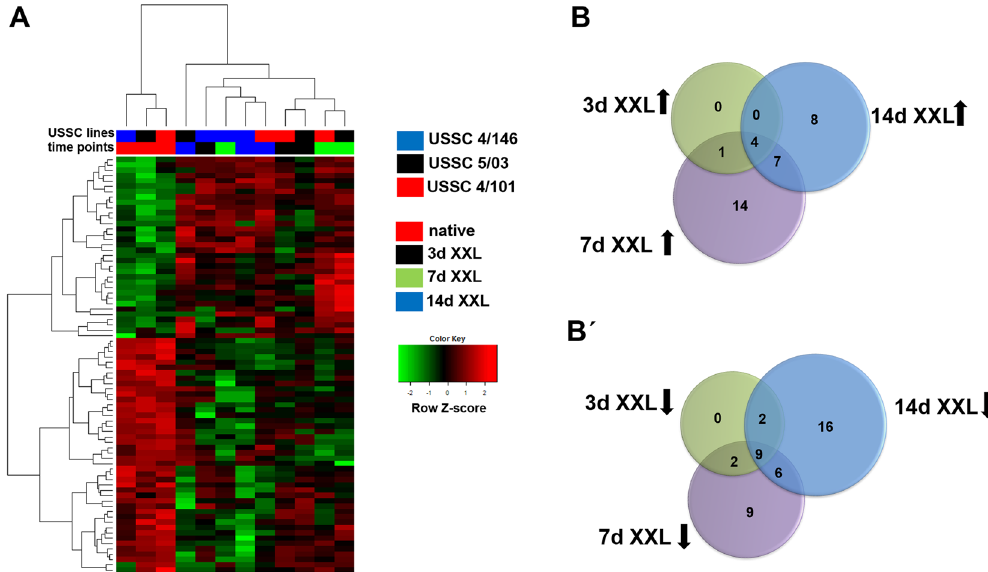
Figure 4. miRNA expression analysis in USSC and XXL-USSC. ( A ) Heat map of differentially expressed miRNAs in USSC lines 4/101, 4/146, and 5/03 (p < 0.01, q < 0.05, FC > 1.5) at time points native, 3d, 7d, 14d of XXL-incubation. USSC lines and time points are color-coded at the top of the heat map. ( B, B’ ) Venn diagrams showing numbers of upregulated ( B ) and downregulated ( B’ ) miRNAs at the respective time points of XXL incubation (3d, 7d and 14d), each compared to native untreated USSC. Black arrows denote the regulatory